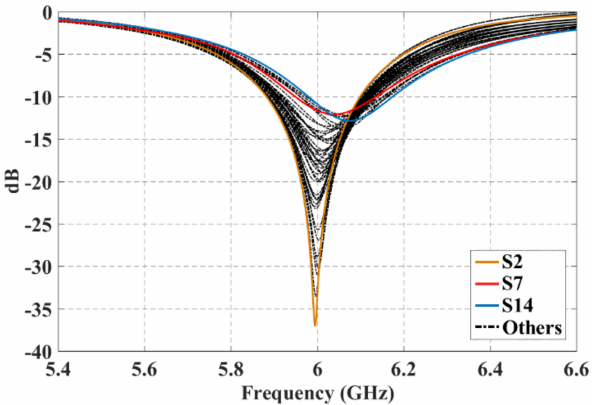
Figure 10. Active reflection coefficients for the 49 antenna elements of the 7 × 7 planar array of the configuration 1 at φ 0 = 90 ◦ and θ 0 = 40 ◦ .